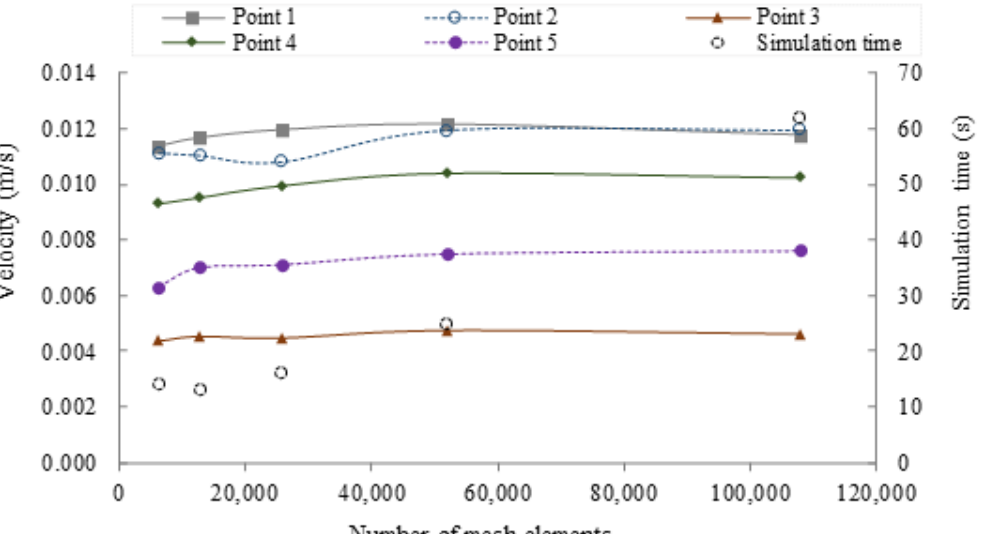
Figure 4. Mesh convergence analysis for the one-loop torus microreactor. Five points along the computational domain were selected for the analysis and plotted as a function of number of mesh elements. Additionally, the simulation time for the different levels of meshing is presented as dotted circles.